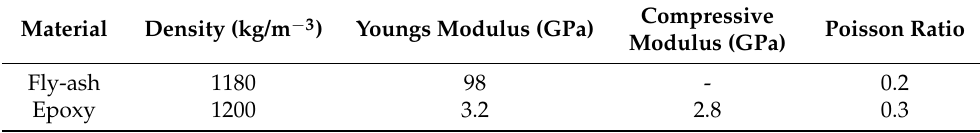
Table 2. Properties of fly-ash and epoxy material.